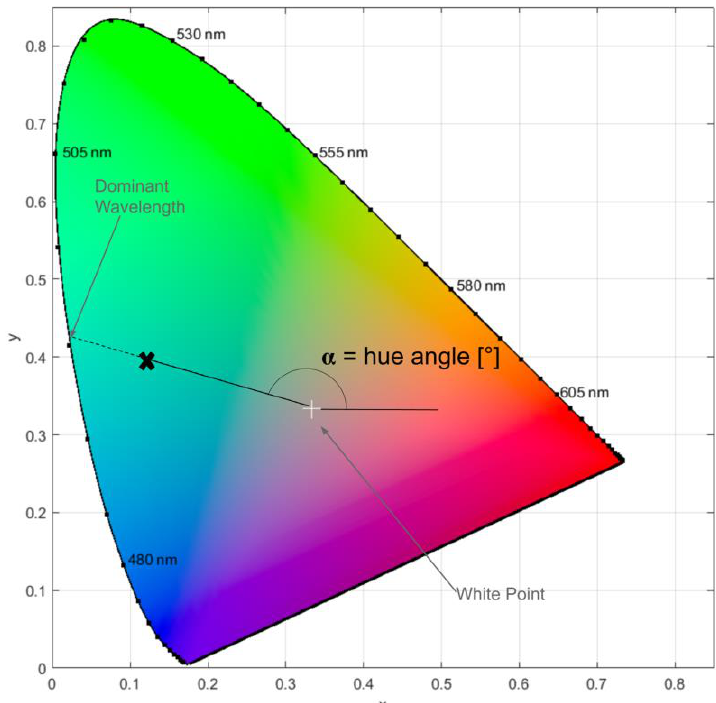
Figure 1. Diagram of the CIE 1931 color space with key terms (dominant wavelength, hue angle) noted. The bold X represents the location of an arbitrary color, the dominant wavelength of which is determined by the straight line extending from the white point through it to the edge of the color space. The x- and y-values on the axes are chromaticity coordinates. Plot created using code adapted from [15,16].